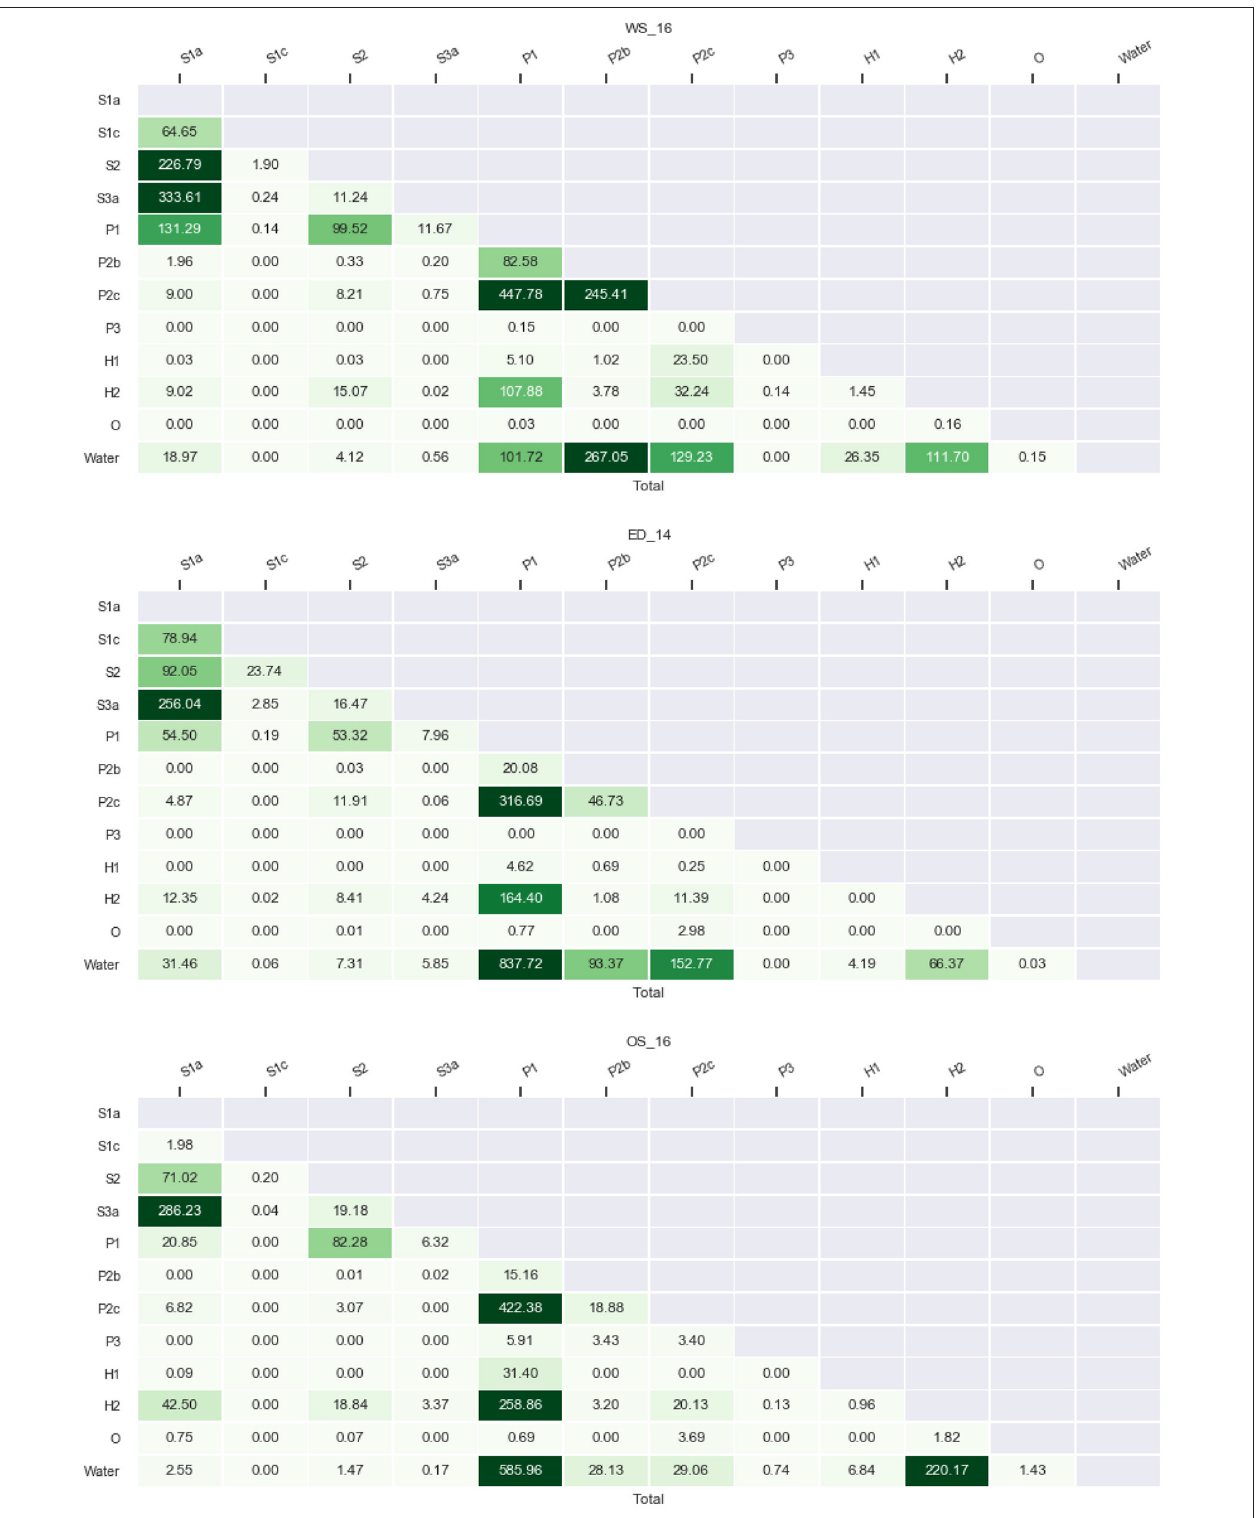
Frontiers in Marine Science |